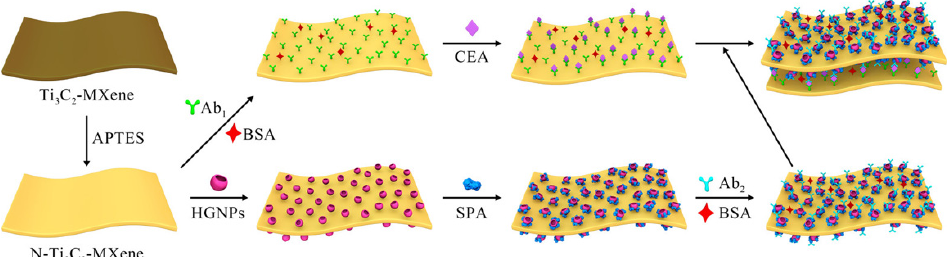
Figure 7. Plan of the prepared ‘SPR biosensor’ detection method. (Reprinted with permission [185].